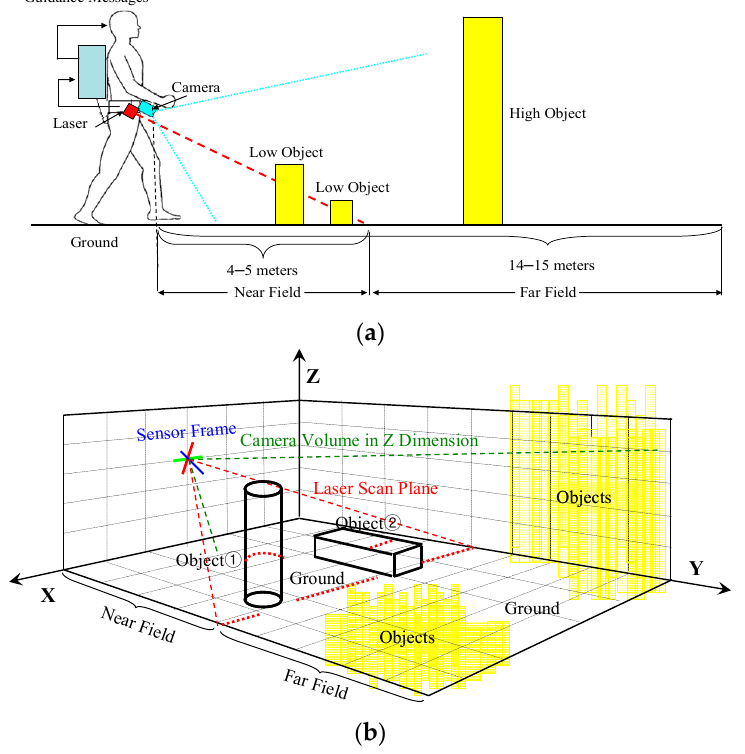
Figure 1. Dual-field sensing scheme. ( a ) Dual-field sensing scheme in 2D side view; ( b ) Dual-field sensing scheme in 3D frame.